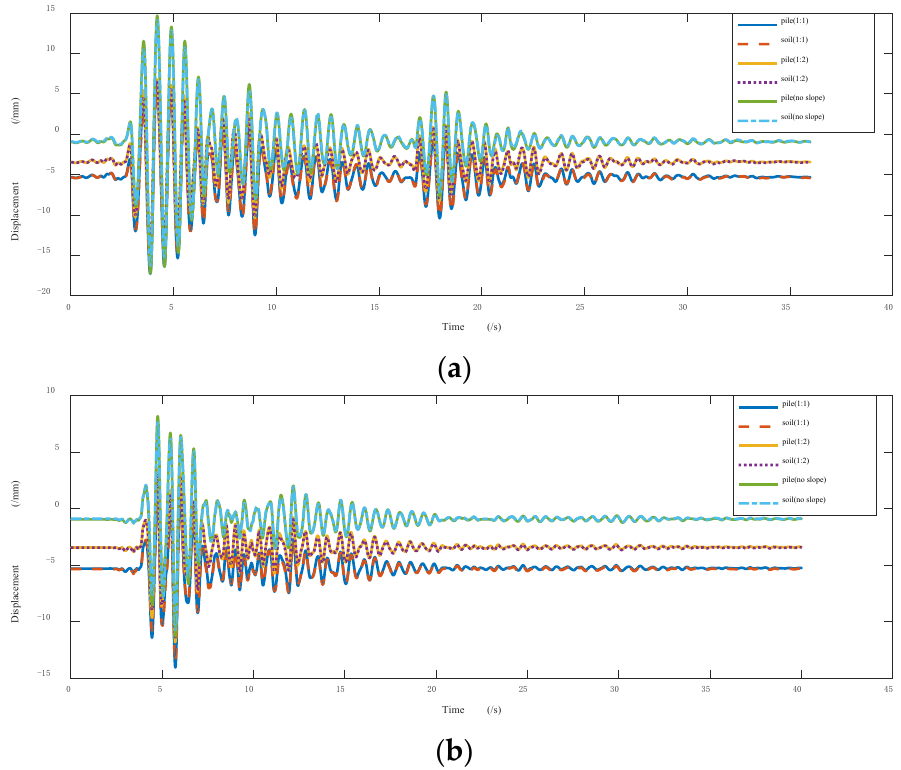
Figure 11. Displacement time history curve of pile and soil (at 6 m buried depth): ( a ) working condition 6; ( b ) working condition 18.